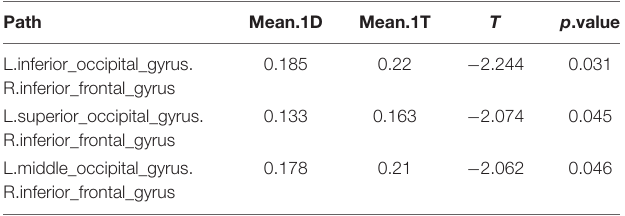
TABLE 5 | Differences in network activation: Five-note transposing (5T) versus one-note transposing (1T). Path